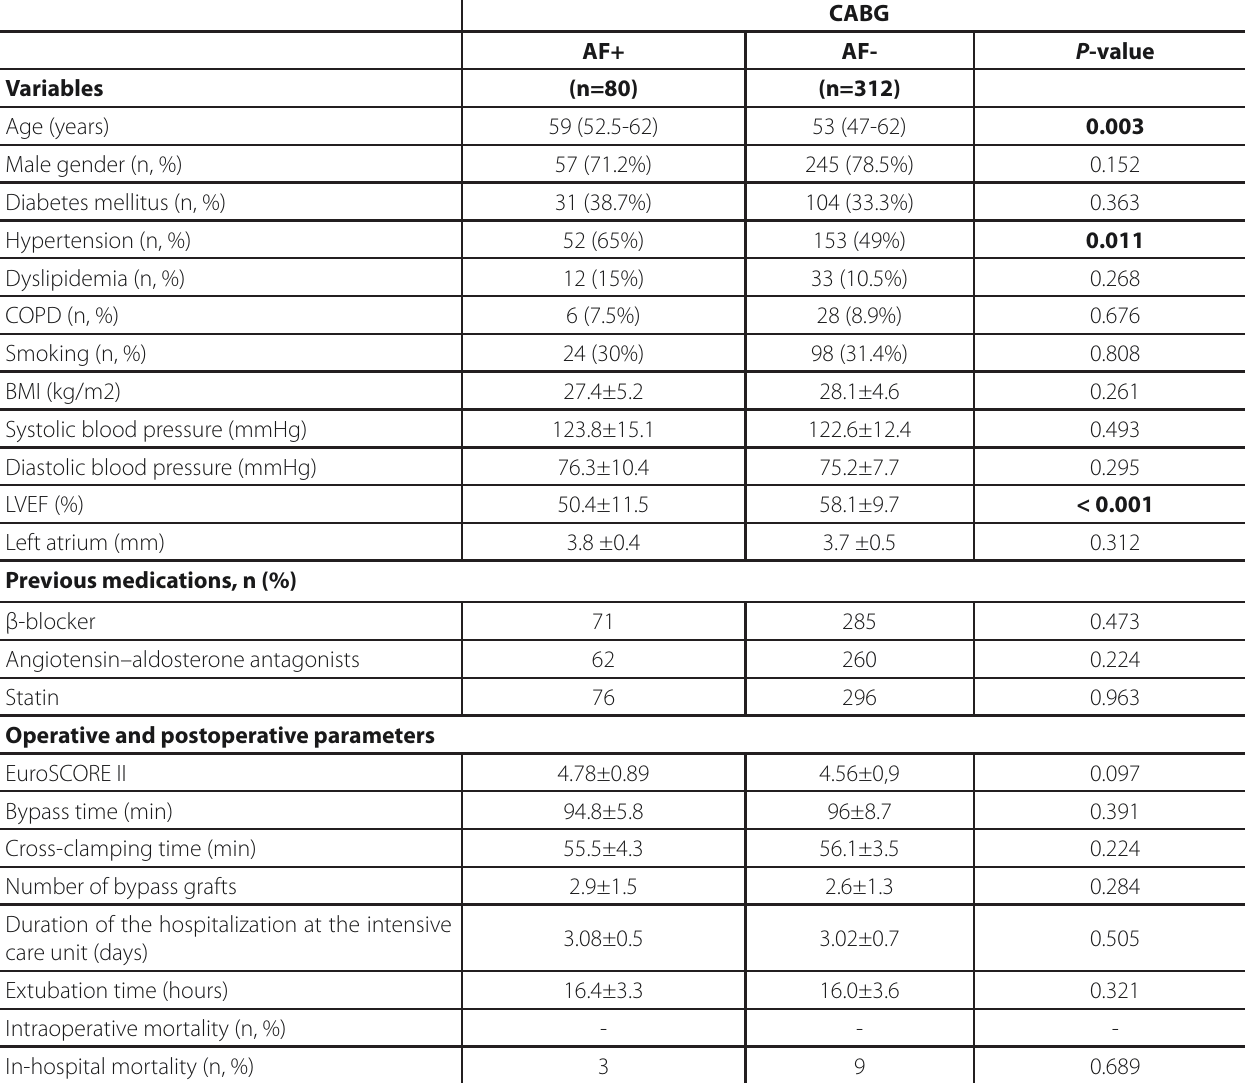
Table 1. Demographic characteristics of the study